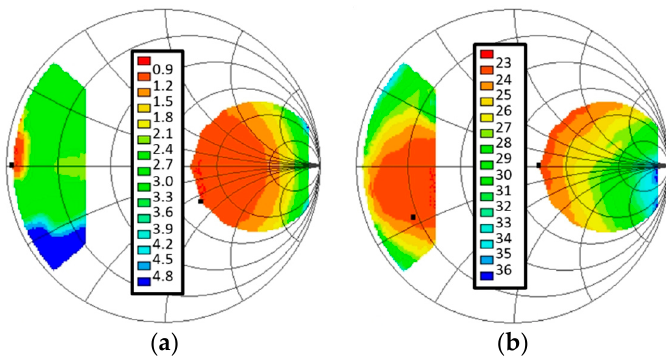
Figure 2. Simulated impedance contour based on the generic topology shown in Figure 1: ( a ) Insertion loss contour; ( b ) Isolation contour. (Both in unit of dB)